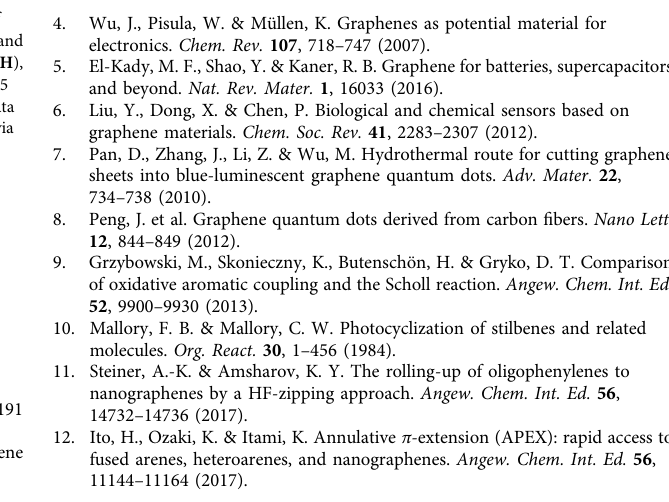
Fig. 6 Synthesis of more sophisticated nanographenes. a Synthesis of O6H DPT through the association of oxidative cyclo-rearrangement with Scholl cyclization. b Crystal structure of O6H DPT . c UV-vis absorption (red) and fl uorescence (yellow) spectra of O6H DPT (in CH 2 Cl 2 , c = 2.0 × 10 − 5 mol L − 1 ). d Synthesis of O8H ’ Br via oxidative cyclo-rearrangement and sequential formation of CO8H ’ PDI via further fusion with a PDI moiety. e Stacking of CO8H ’ PDI molecules in a crystal (alkyl side chains and hydrogen atoms are omitted for clarity). f UV-vis absorption spectrum of CO8H ’ PDI (in CH 2 Cl 2 , c = 2.0 × 10 − 5 mol L − 1 ). Calculated excitation energies and oscillator strengths of CO8H ’ PDI-CH3 (the alkyl side chains are replaced with methyl groups for simplicity) are displayed as sticks (the fi rst 10 excitations). g HOMO and LUMO of CO8H ’ PDI-CH3